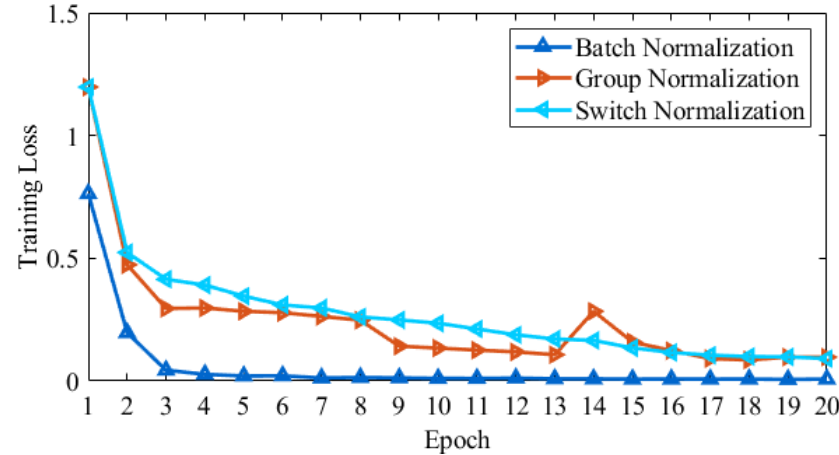
Figure 4. Proposed model training and validation loss.